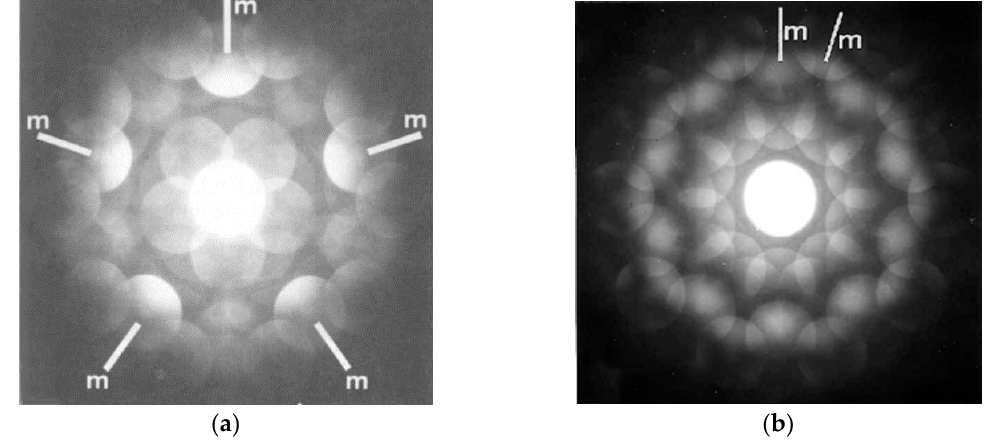
Figure 4. CBED patterns taken along the periodic axis of decagonal QCs: ( a ) Al 70 Cu 4 Co 26 (P10m2) and ( b ) Al 70 Ni 20 Rh 10 (P10 5 /mmc) (reproduced from reference [75] and reference [31], respectively, with permission).